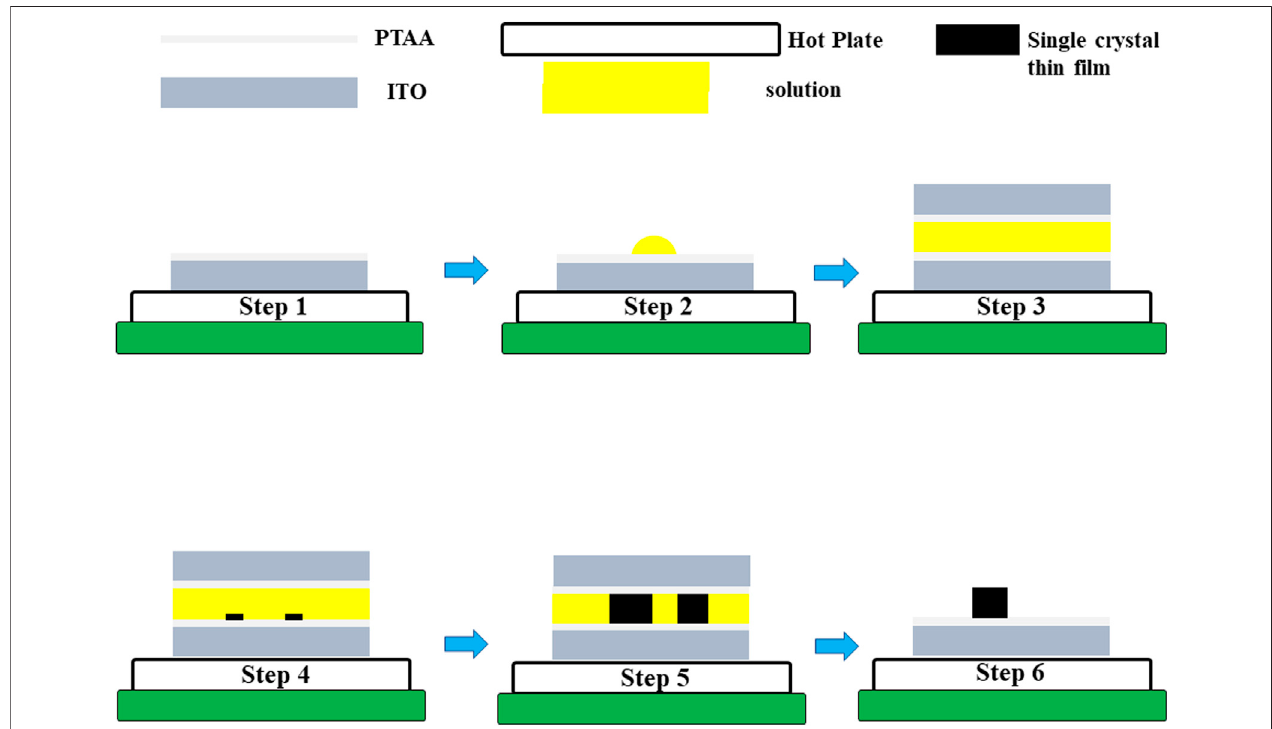
FIGURE 1 | Schematic illustration of single-crystal thin fi lm growth process by using the space-con fi ned method.